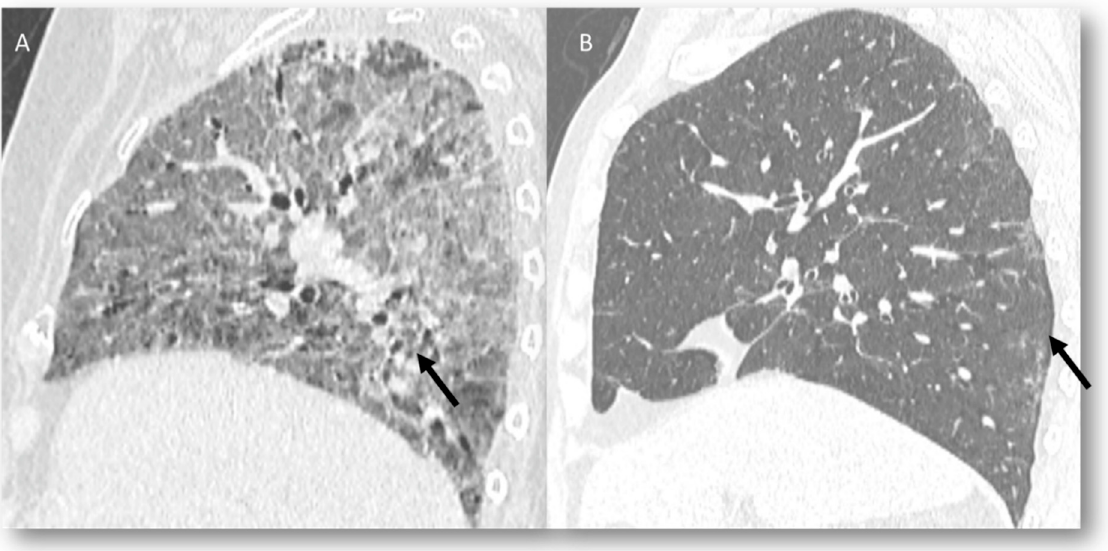
Figure 5. CT assessment (( A ): sagittal plane) of CIP: acute interstitial pneumonia (AIP)–acute respiratory distress syndrome (ARDS) pattern (arrow). After steroids treatment (( B ): sagittal plane); subpleural distribution bilaterally of ground-glass opacities (arrow).